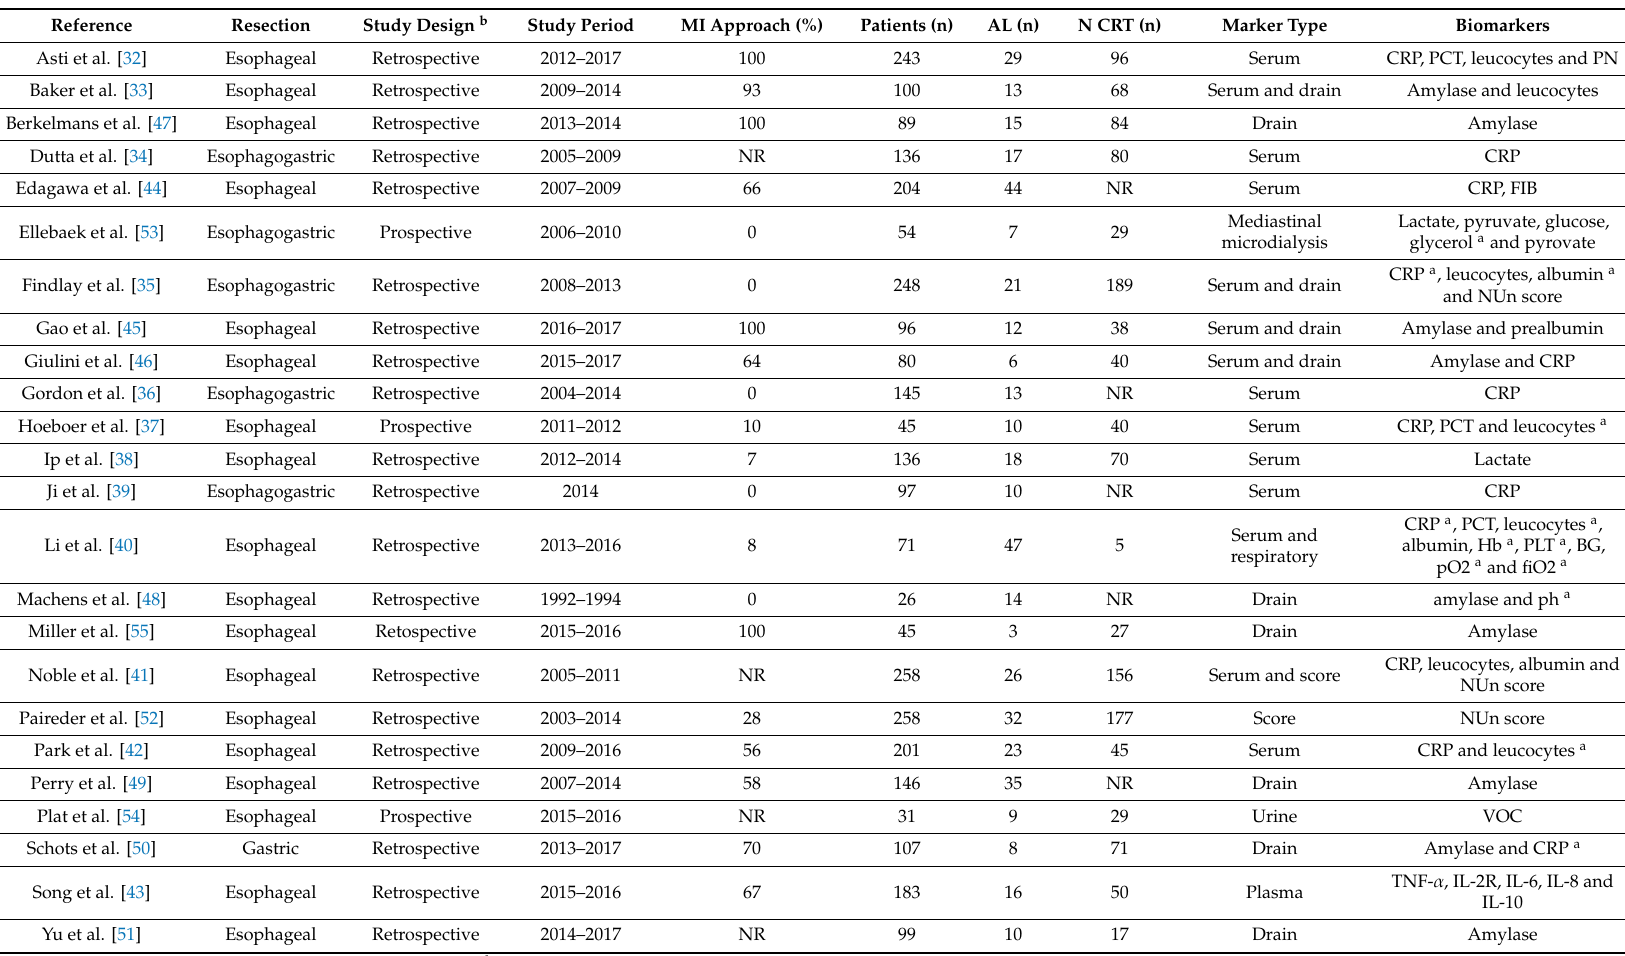
Table 1. Summary of included studies evaluating biomarkers for detecting anastomotic leakage in gastroesophageal